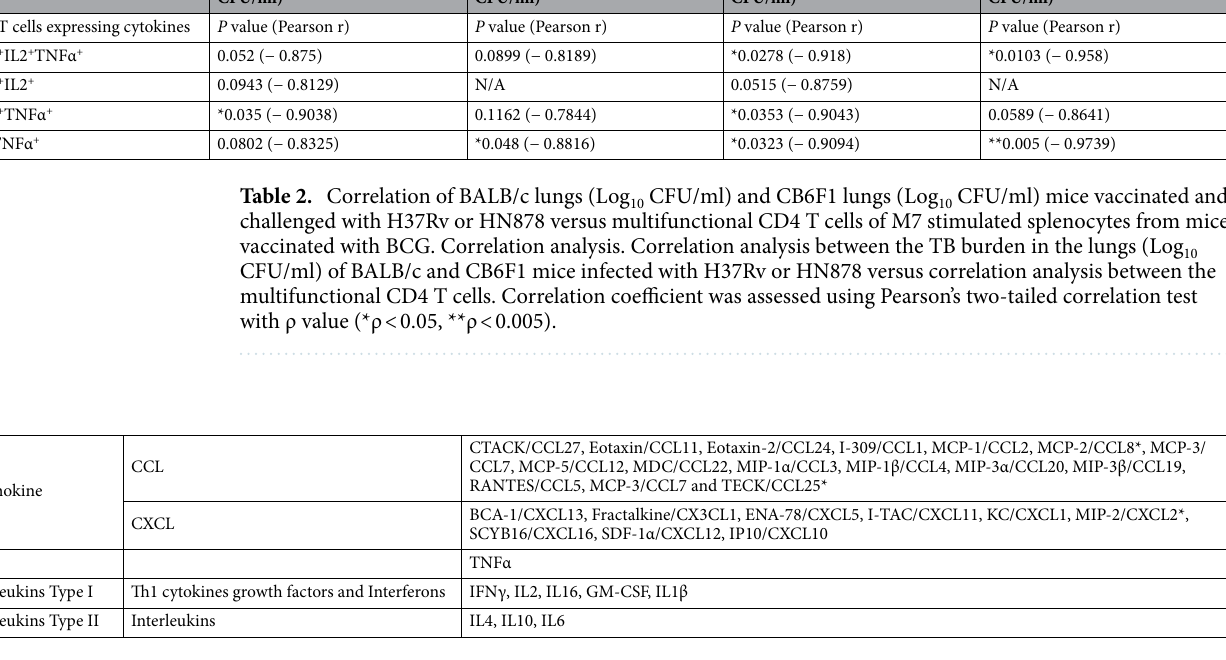
Table 3. Classification of examined cytokines and chemokines in the M7 stimulated supernatants of splenocytes and lung cells from BCG vaccinated BALB/c and CB6F1 mice. *Not analysed for CB6F1 mice (Splenocytes and lung cells) as absent in the Bio-Plex Pro Mouse Chemokine